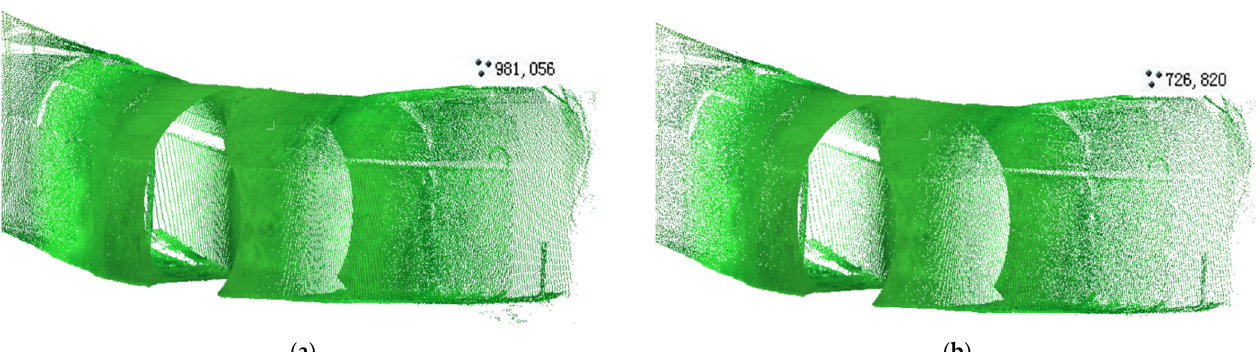
Figure 8. Before and after point cloud denoising. ( a ) Point cloud before denoising; ( b ) Point cloud after denoising.